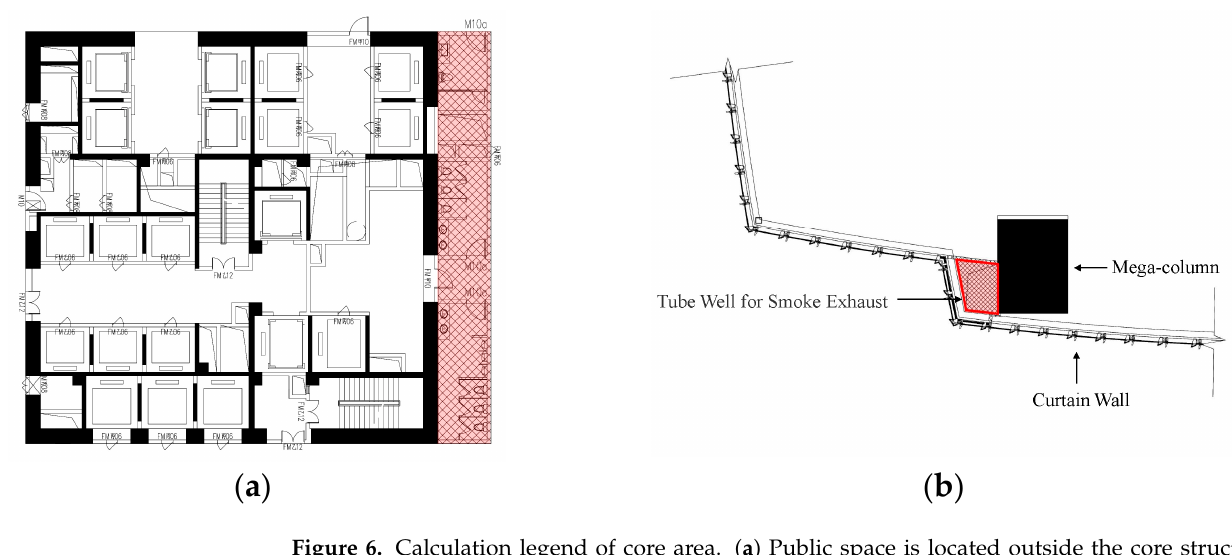
Figure 6. Calculation legend of core area. ( a ) Public space is located outside the core structure, ( b ) Equipment tube wells arranged outside the core